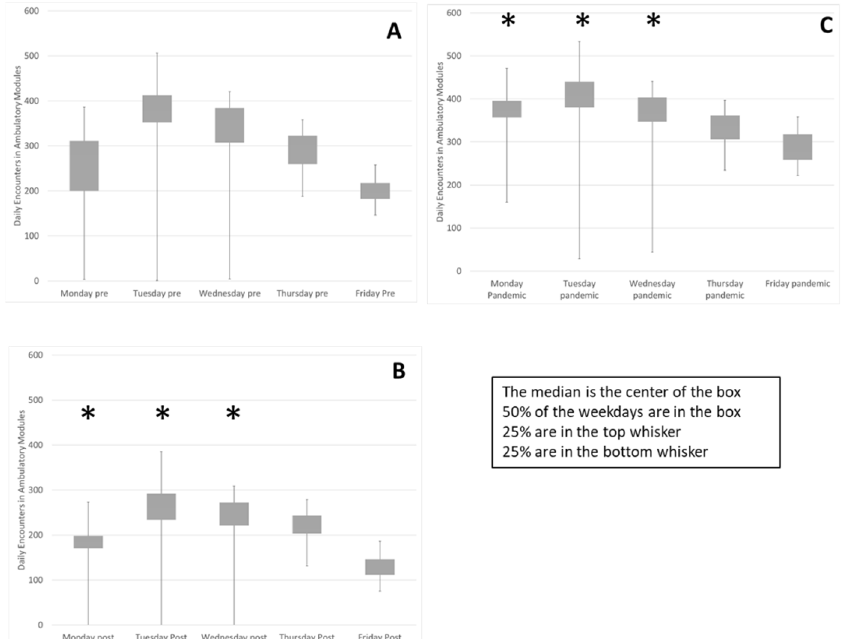
Figure 2. Weekly variability in daily encounters was reduced as well as variability between weekdays. The encounters on each weekday during the three evaluation periods are summarized in box plots ( A ) Pre, ( B ), Post and ( C ), Pandemic. Sustained reduction of variance for Mon, Tues & Wed was observed (*) ( F Test Pre-Post and Pre-Pandemic Mon p < 0.0001, p < 0.0001, Tues p < 0.0001, p < 0.0003, Wed p < 0.0001, p < 0.03 ). The change on Monday demonstrated by reduction of the coefficient of variation (Standard deviation/mean) from 0.48 to 0.12 (smaller box) and variability decreased on Tuesday and Wednesday due to reduction of low utilization outliers, (smaller bottom whisker). Friday and Monday activity level increased while Tuesdays decreased as proportion of weekly total (flatter row of boxes). Two chi-square tests of independence showed that there was a significant and sustained association between the schedule change and activity distribution between the weekdays, (Pre-Post X 2 (4, N = 25,293) = 94, p < 0.0001, Pre-Pandemic X 2 (4, N = 43,431) = 557, p < 0.0001).